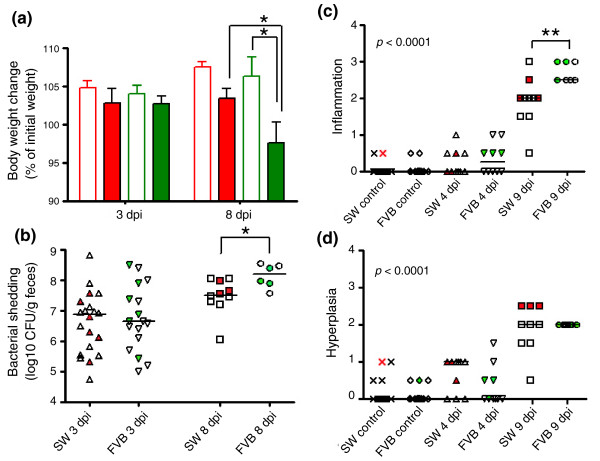
C. rodentium infection in adult susceptible inbred FVB mice and resistant outbred SW mice. (a) Significant weight loss was observed in infected FVB mice at 8 dpi (p < 0.05). Weight was normalized and expressed as percent change of initial baseline. Red and green indicate SW and FVB mice, respectively; open and filled bars represent uninoculated and infected mice, respectively. Values are mean ± standard error of the mean. (b) Fecal bacterial counts were similar in both lines of mice at 3 dpi, but FVB mice had higher bacterial shedding at 8 dpi (p < 0.05). Bacterial counts were log10 transformed. (c) FVB mice infected with C. rodentium developed colonic inflammation that was significantly more severe than the milder colitis in SW mice at 9 dpi (p < 0.0001). (d) Infected FVB and SW mice developed comparable hyperplasia at 9 dpi. Experimental groups included 20, 10, and 7 uninoculated control, 4 dpi, and 9 dpi FVB mice, respectively, and 16, 10, and 10 SW mice in the corresponding groups. Each symbol represents one animal; filled symbols in red or green represent SW or FVB mice selected for array analysis. Mean or median lines for each group are presented. *p < 0.05; **p < 0.01.